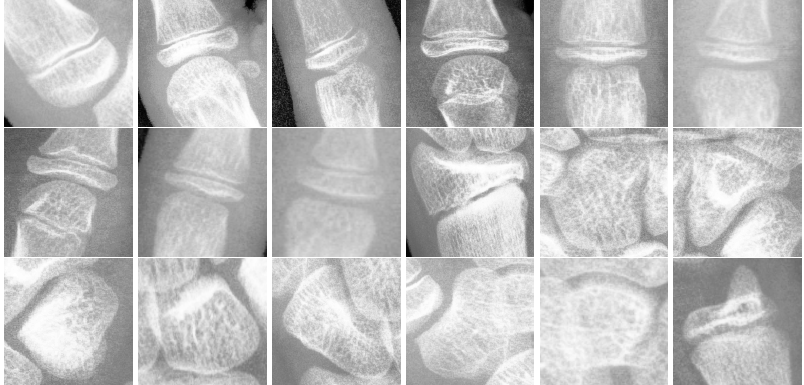
Figure 6. 18 ROI extraction